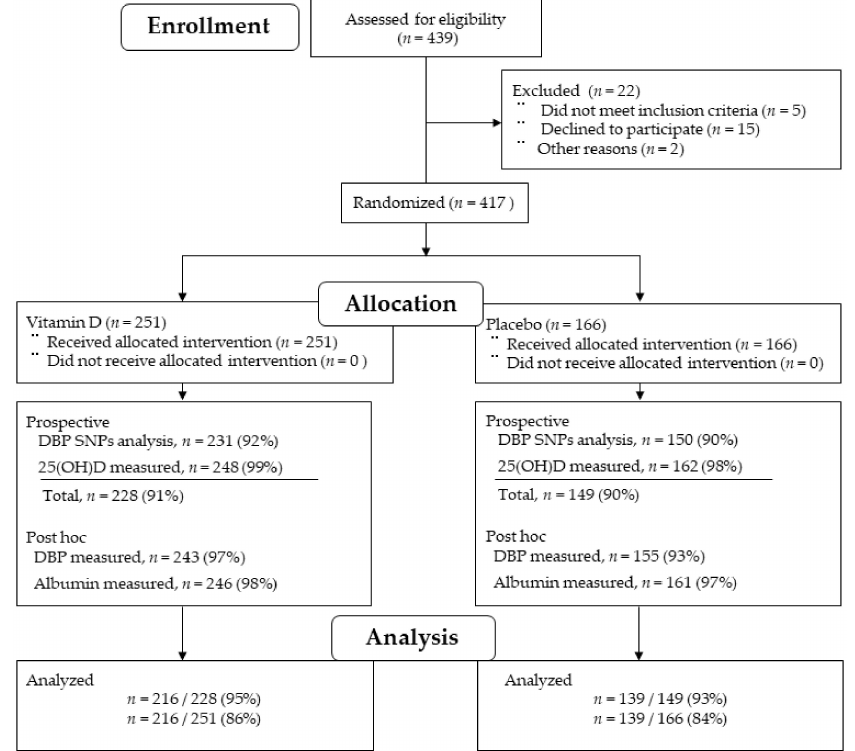
Figure 6. Flow diagram of patients. DBP: vitamin-D-binding protein; SNP: single nucleotide polymorphism; 25(OH)D: 25-hydroxyvitamin